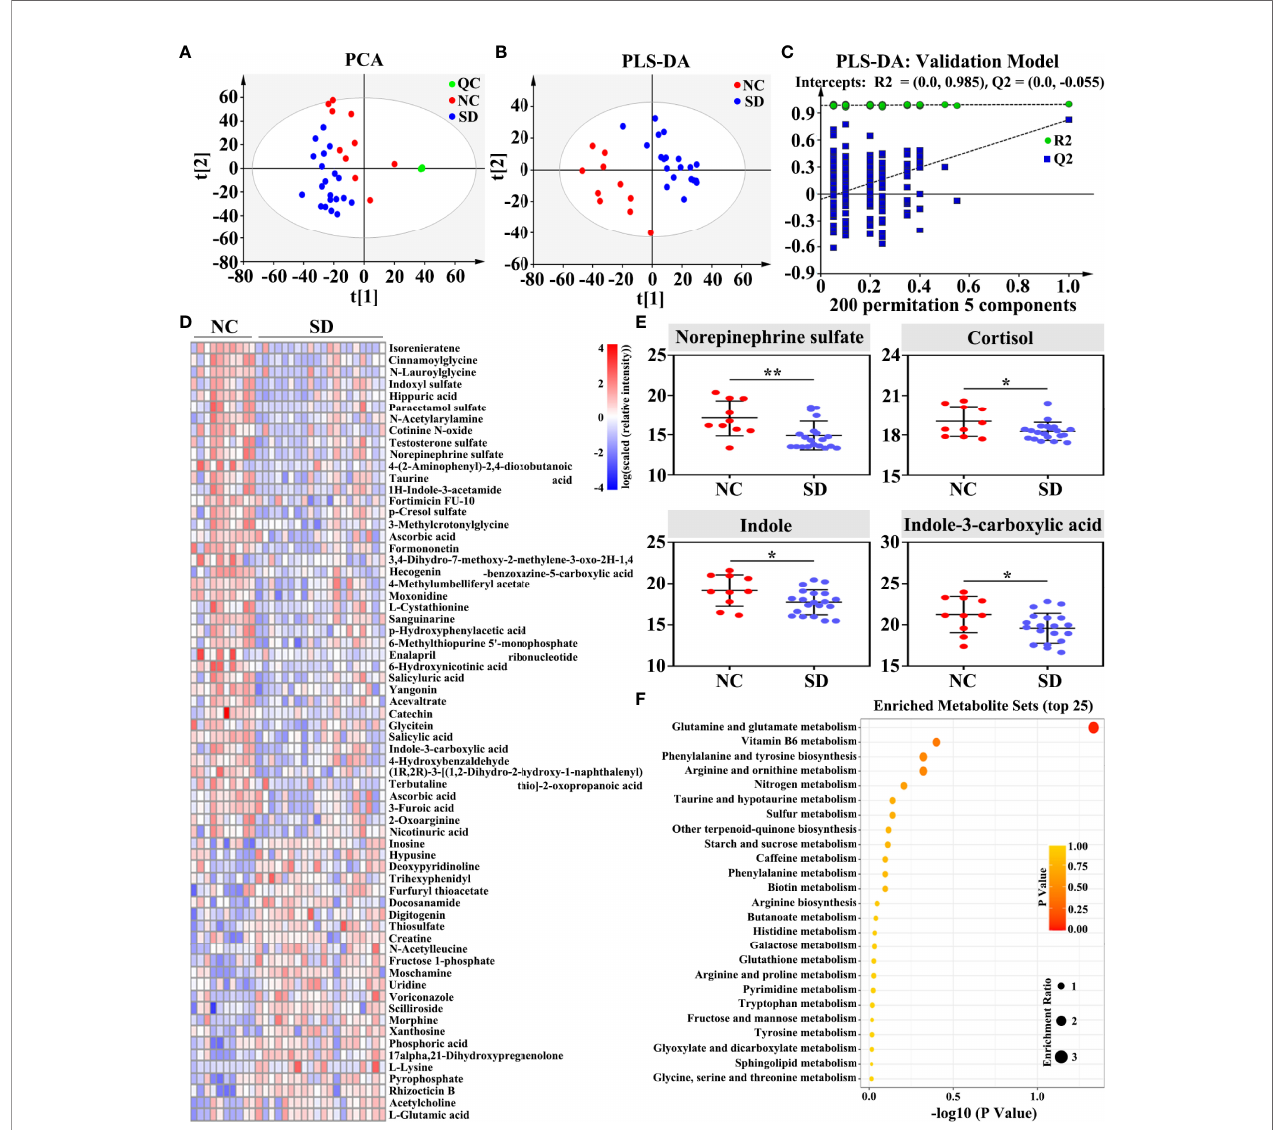
FIGURE 3 | Effects of sleep deprivation (SD) on gut metabolite in rhesus monkeys (RMs). (A) The PCA score plot revealed that SD RMs can be clearly separated from controls by fecal metabolites (R2X = 0.674 and Q2 = 0.328). (B) The PLS-DA score plot demonstrated that fecal metabolites from SD RMs clustered well away those from controls (R2Y = 0.43 and Q2 = 0.825). (C) The results of the PLS-DA model were validated by the permutation test ( n = 200, R2Y = 0.985, and Q2 = − 0.055). (D) Sixty-six signi fi cantly differential metabolites ( p < 0.05, VIP > 1 and |log(FC)| > 1.5) were shown in the heatmap. (E) Four metabolites implicated in stress response and tryptophan metabolism, namely, norepinephrine sulfate, cortisol, indole, and indole-3-carboxylic acid, were further compared and shown using a box map. (F) An overview of enriched metabolite sets for 227 differential metabolites using the online software MetaboAnalyst 5.0. Differences were denoted as follows: * p < 0.05; ** p < 0.01. QC, quality control sample; NC, normal control